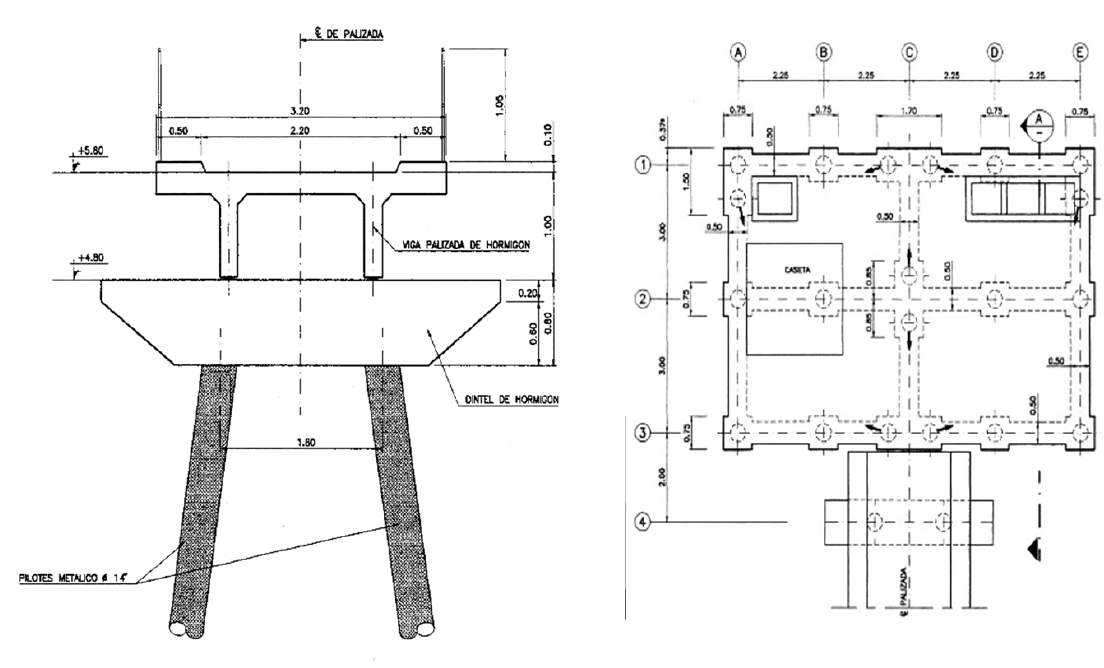
Figure 1. 1980s ( left ) and 2017 ( right ) aerial photos of the Pont del Petroli. Originally constructed for industrial purposes, the pier is now open to the public. (Sources: Concepció Riba).